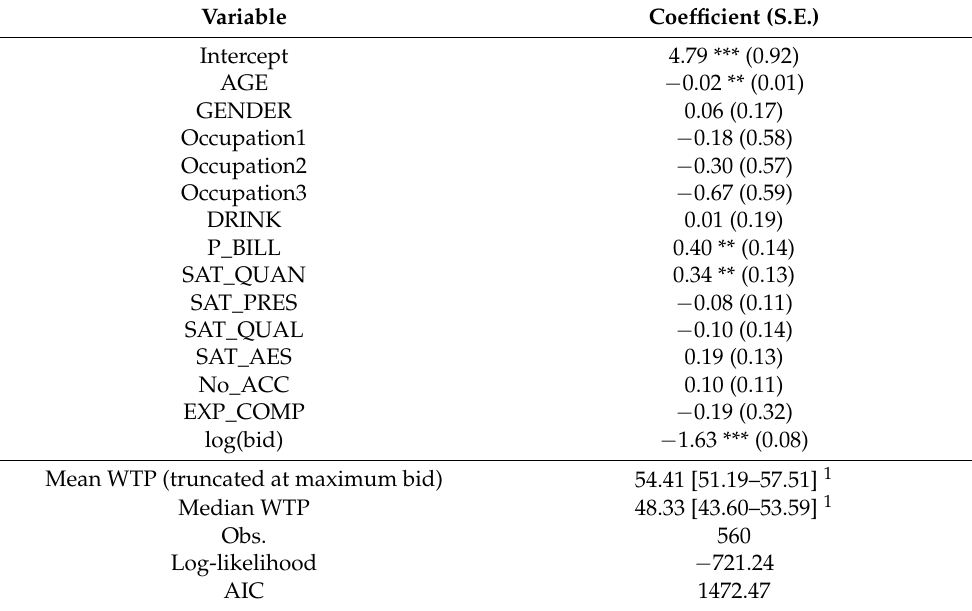
Table 3. Individual-level willingness to pay (WTP) estimated using the double-bounded dichotomous choice (DBDC) model with covariates that account for sociodemographic characteristics and customer